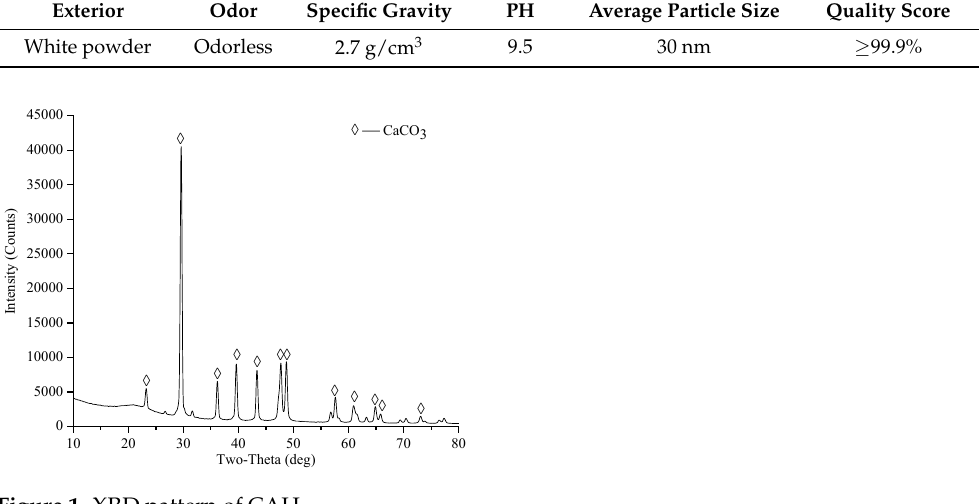
Figure 1. XRD pattern of CAH.